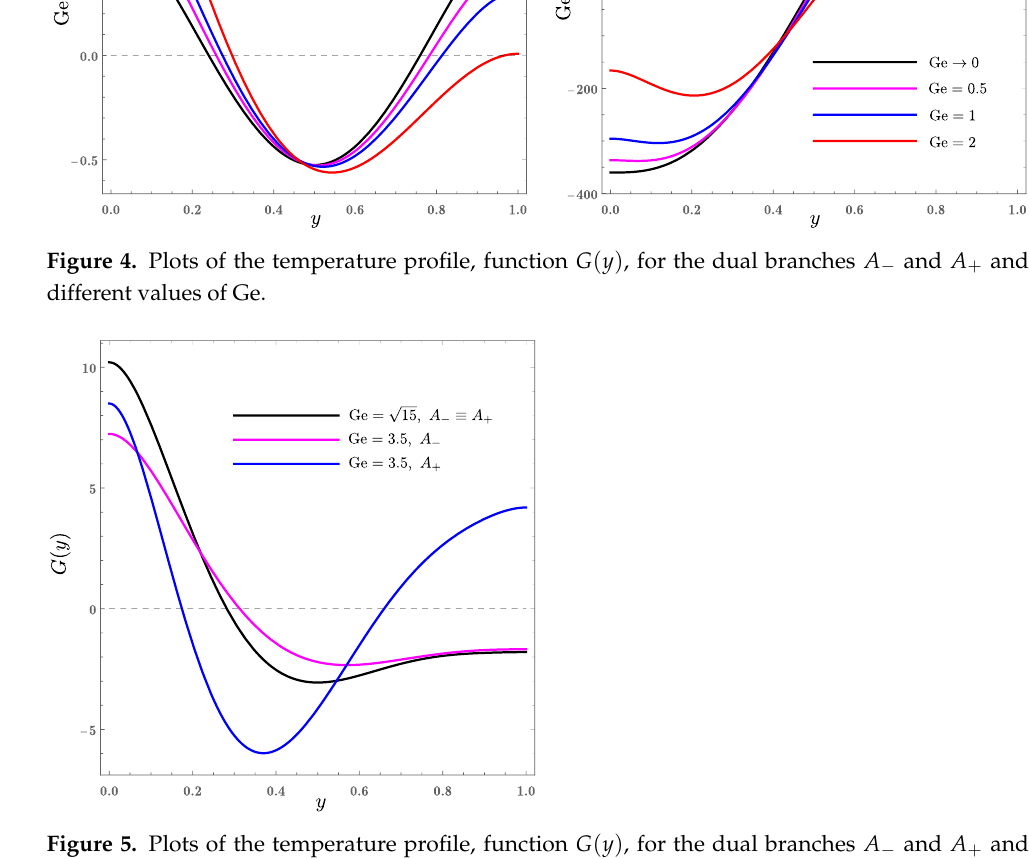
Figure 5. Plots of the temperature profile, function G ( y ) , for the dual branches A − and A + and different values of